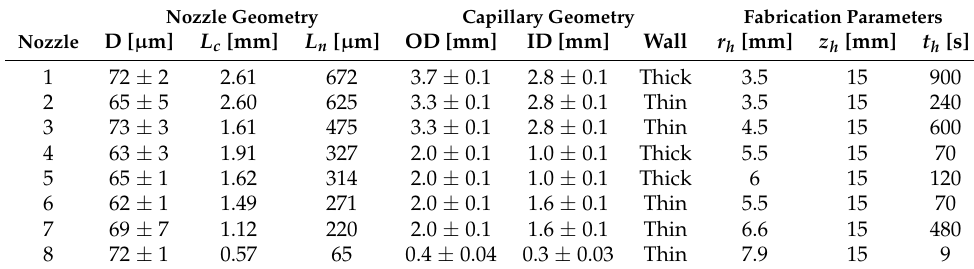
Figure 3. Characteristic geometrical parameters of the nozzle inner shape ( a ), and mean profile of the nozzles ( b ). In the latter, the origin z = 0 is located at the nozzle neck, and the line colour indicates the nozzle number in Table 1. Table 1. Nozzles geometry and fabrication